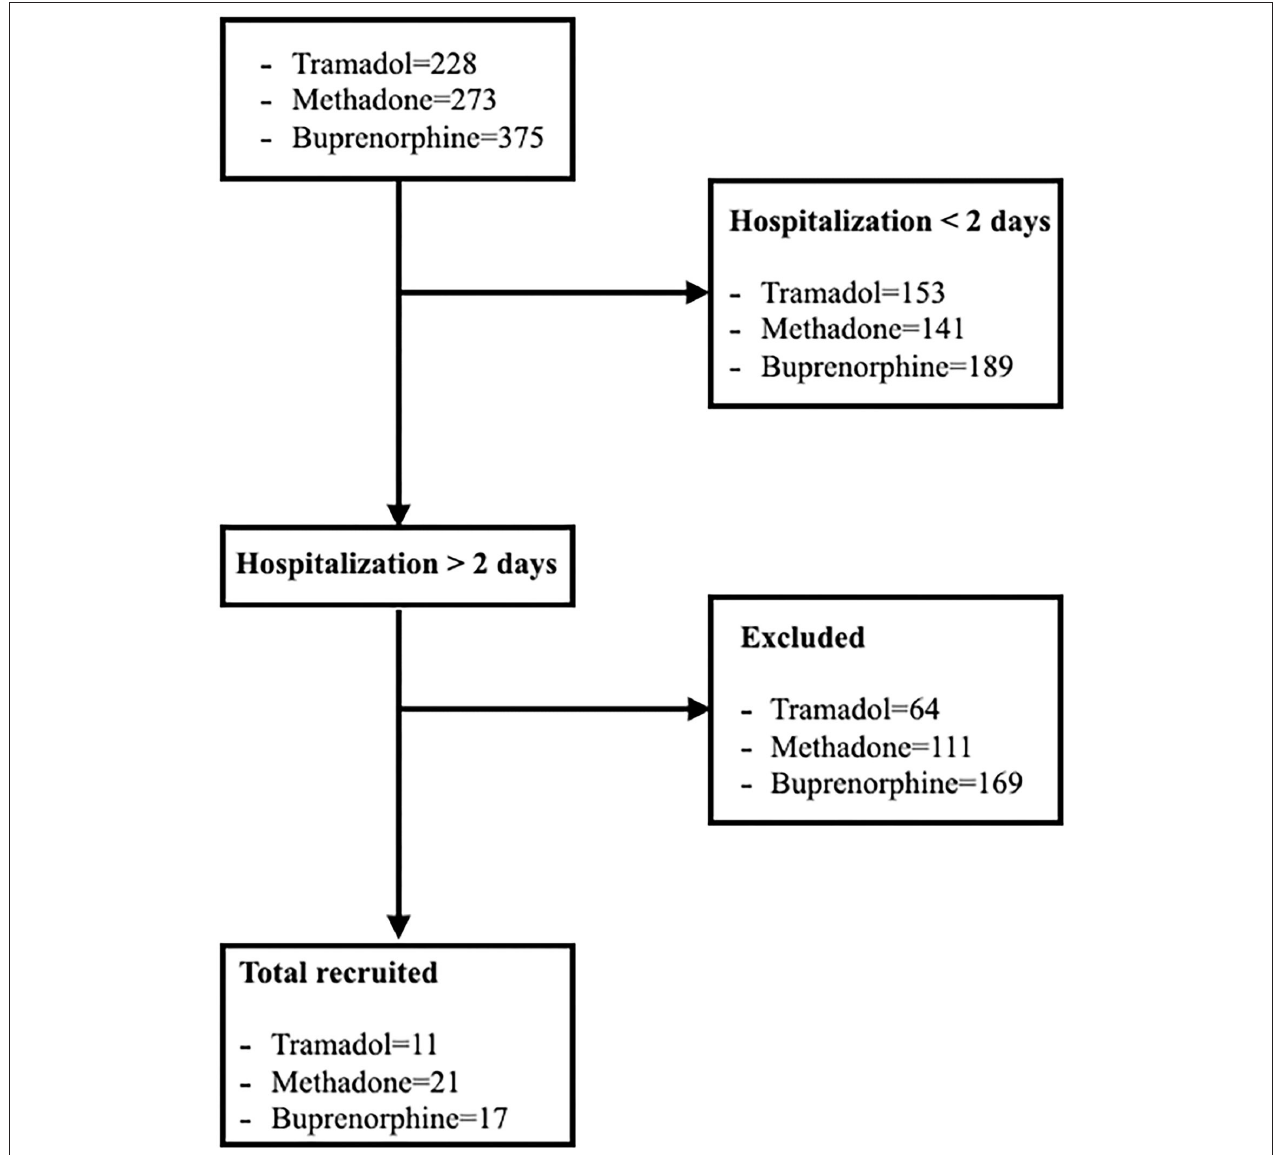
FIGURE 1 | Flow diagram illustrating enrollment, inclusion, allocation process of dogs hospitalized and treated with tramadol, methadone and